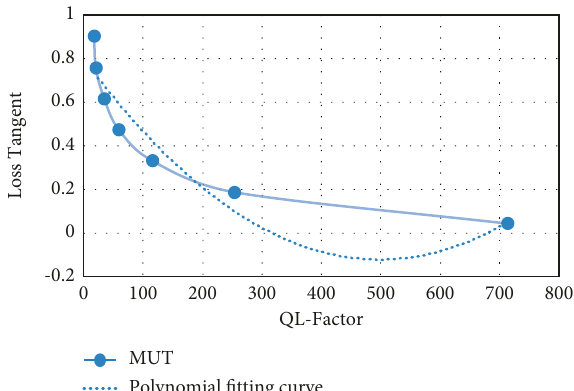
Figure 12: Simulated polynomial fitting curve of loss tangent. Thus, the simulated extracted equation of the loss tangent is given